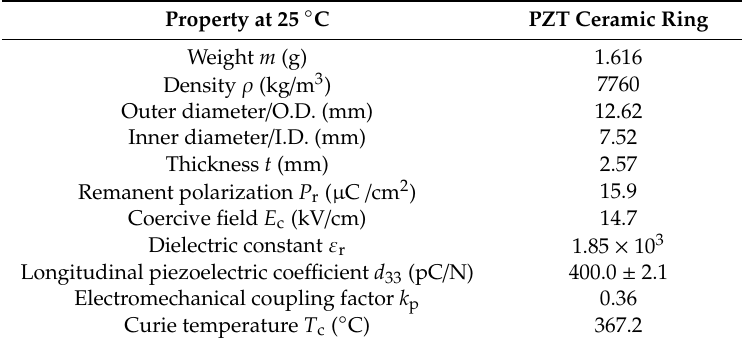
Table 3. Room-temperature physical properties of PZT ceramic rings.